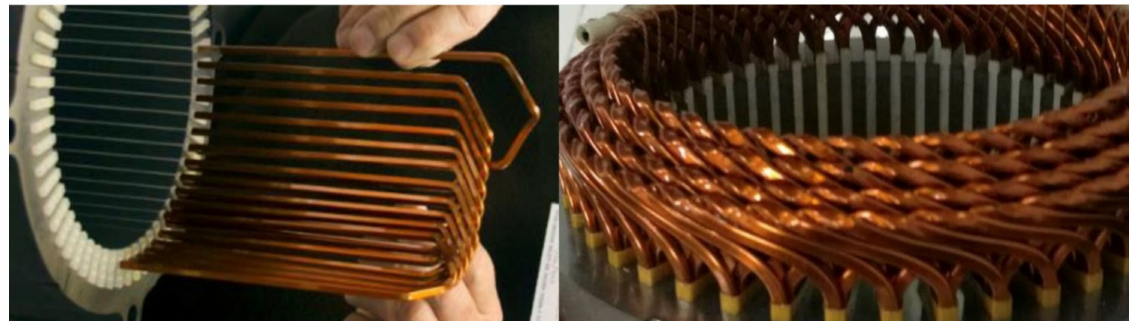
Figure 7. Types of rectangular windings ( Left ) hairpin winding; ( Right ) continuous multi-layer winding